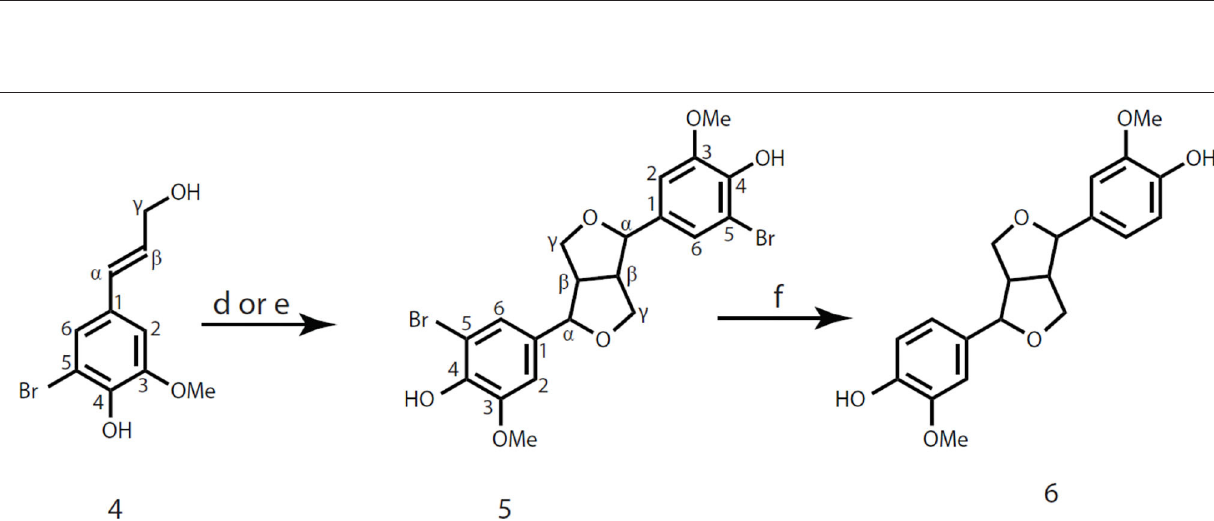
FIGURE 2 | Synthesis of 5-bromoconiferyl alcohol 4. (a) pyridine, acetic anhydride; (b) NaH, triethyl phosphonoacetate, THF; (c) diisobutylaluminum hydride (DIBAL-H), cyclohexane.